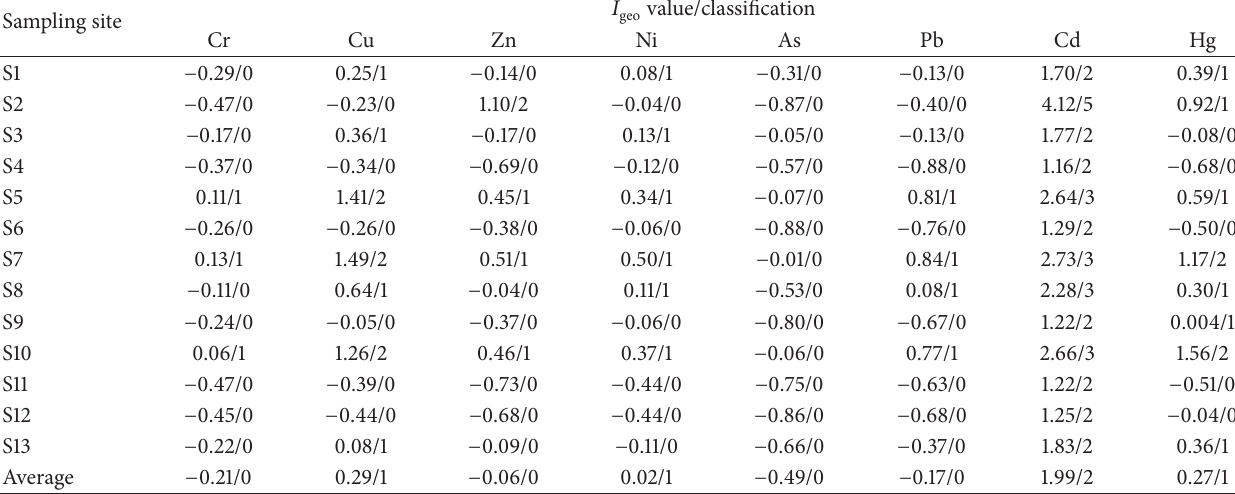
Table 5: The Geoaccumulation Index and classification of heavy metals in sediments from TGR tributaries. Sampling site